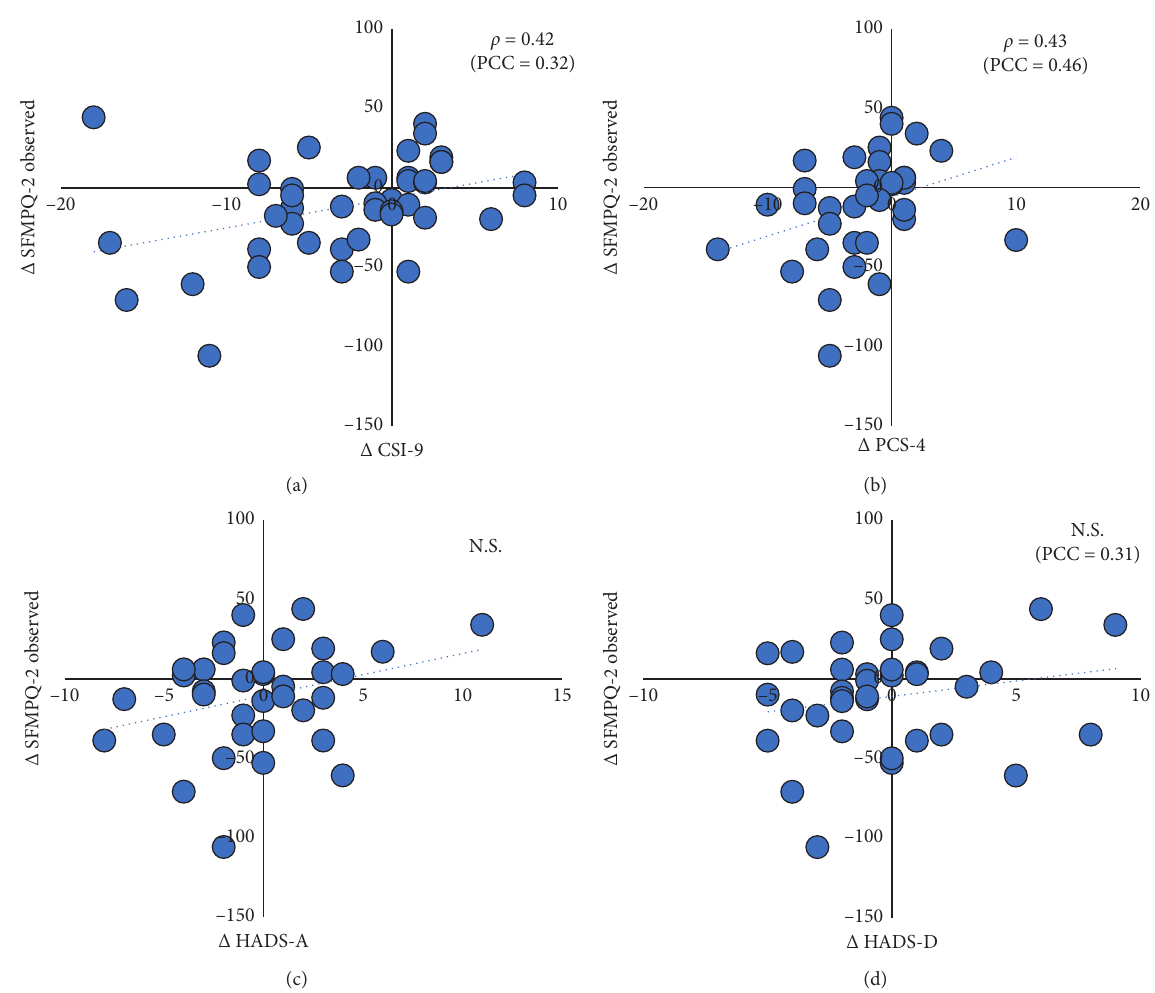
Figure 5: The correlation analysis and scatter plot of ∆ SFMPQ-2 and ∆ CSI-9, ∆ HADS-A, ∆ HADS-D, and ∆ PCS-4. (a) The correlation analysis and scatter plot of ∆ SFMPQ-2 and ∆ CSI-9. (b) The correlation analysis and scatter plot of ∆ SFMPQ-2 and ∆ PCS-4. (c) The correlation analysis and scatter plot of ∆ SFMPQ-2 and ∆ HADS-A. (d) The correlation analysis and scatter plot of ∆ SFMPQ-2 and ∆